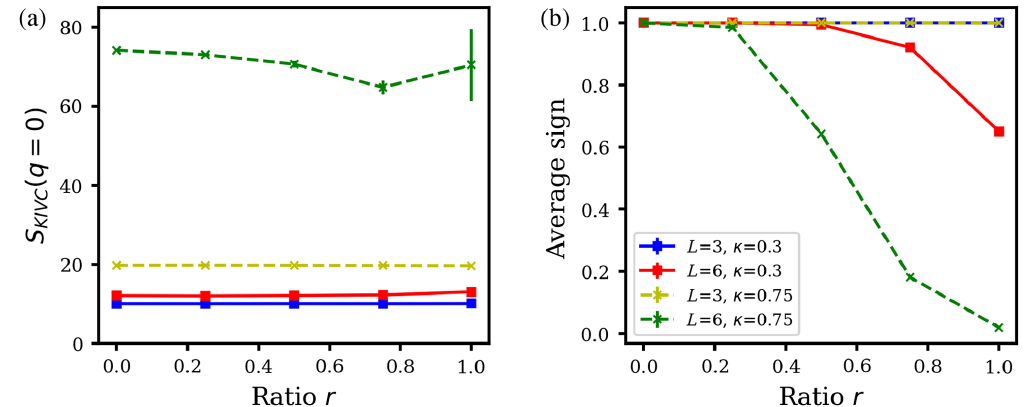
q ¼ 0 Þ and (b) average sign of DQMC weight at T ¼ 0 (Projective FIG. 7. (a) Zero-momentum K-IVC correlation function S K − IVC ð DQMC) as a function of the parameter r , which interpolates the BM model Hamiltonian and the small-angle approximation. Here, r ¼ 0 corresponds to the small-angle approximation, and r ¼ 1 corresponds to the exact BM model Hamiltonian. Note that only at L ¼ 6 and κ ¼ 0 . 75 (K-IVC phase) is the averaged sign close to zero (0.02), which leads to the large statistical error in the correlation function at this parameter value in panel